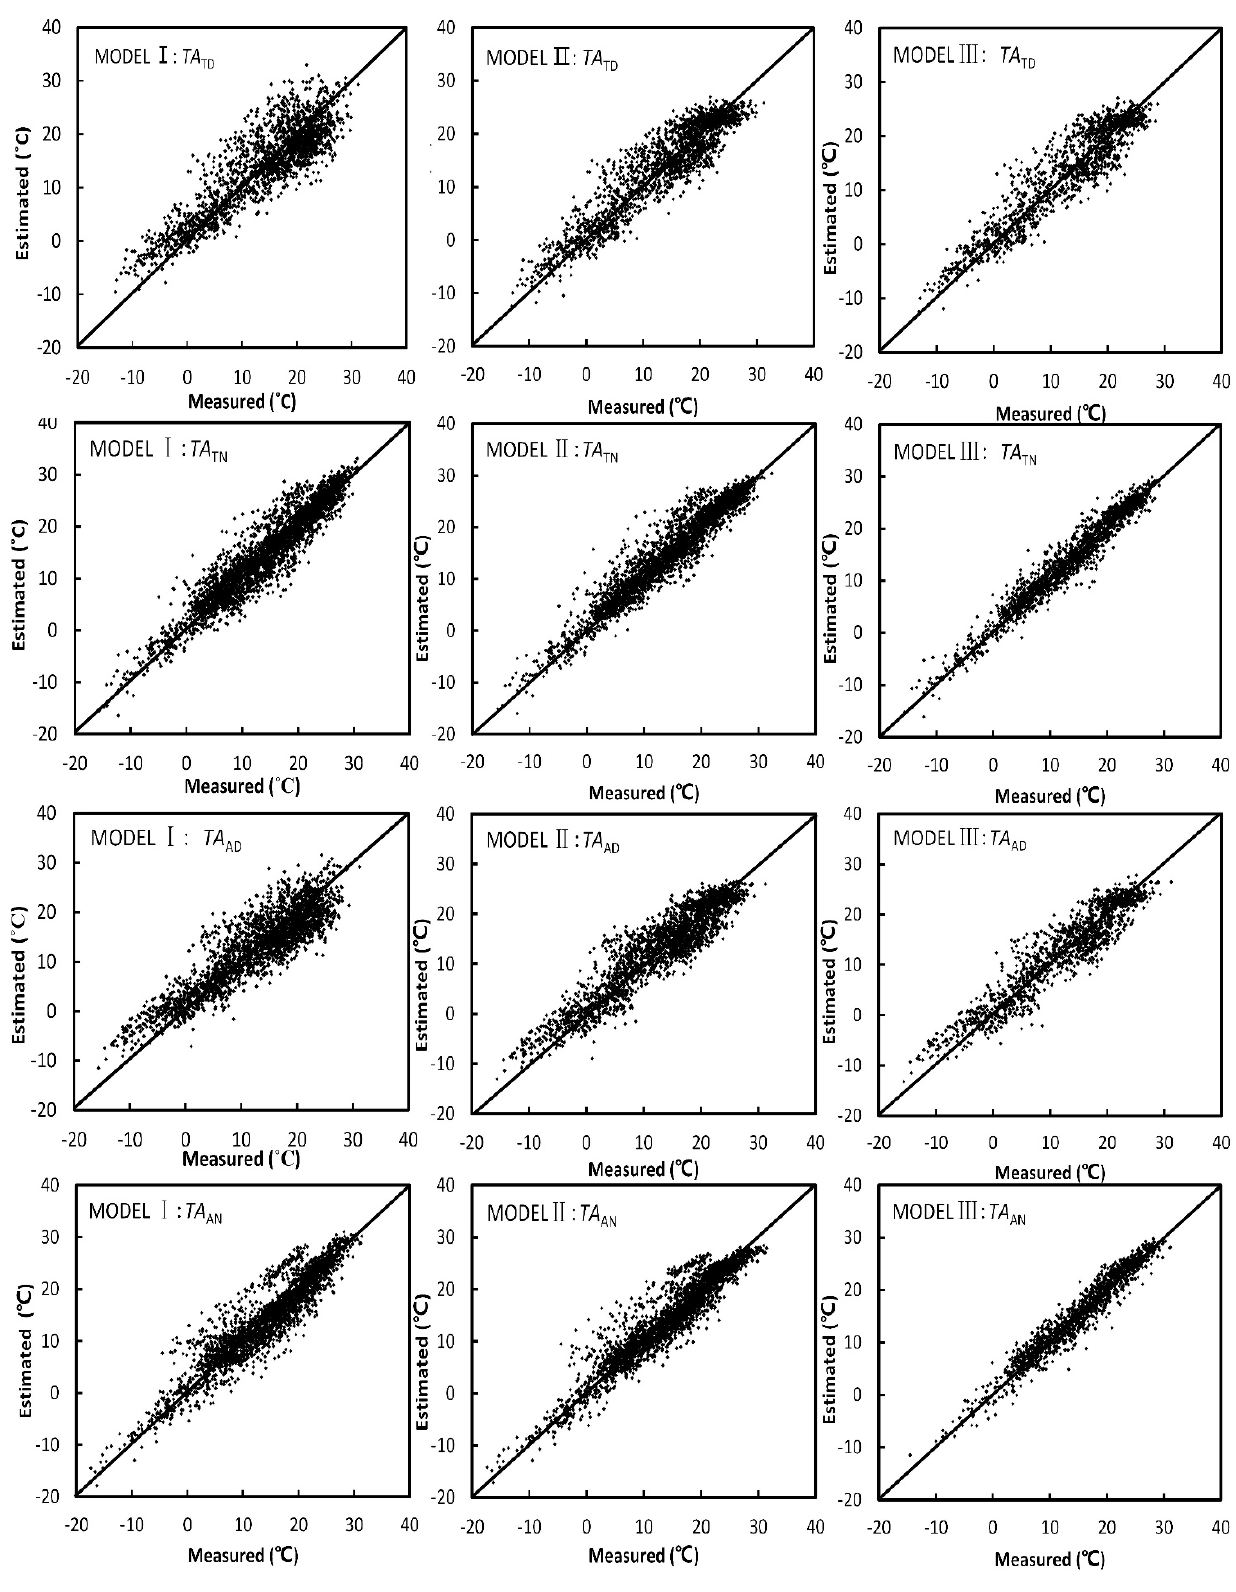
Figure 3. Relationships between the estimated and measured daily mean air temperature ( TA ) based on daytime (D) and nighttime (N) data for the three models (I = all data, II = seasonal data, III = seasonal data from rural stations). Table 4 provides statistical data on the results of each linear